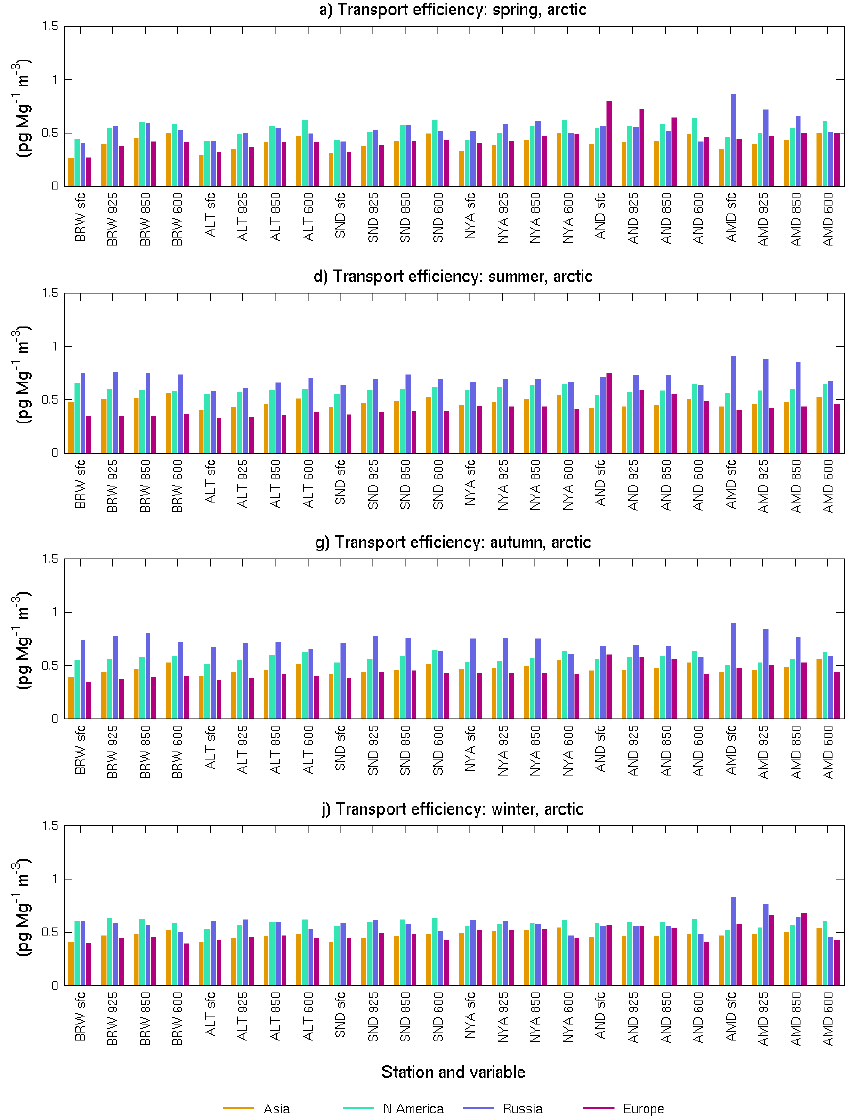
Fig. 6. Shown for the indicated station, level and season is each source region’s transport efficiency. Table 1 identifies whether GEM or TGM efficiencies are calculated at the surface. GEM efficiencies are calculated at all stations at 925, 850 and 600hPa. Stations from each station group are arranged from west to